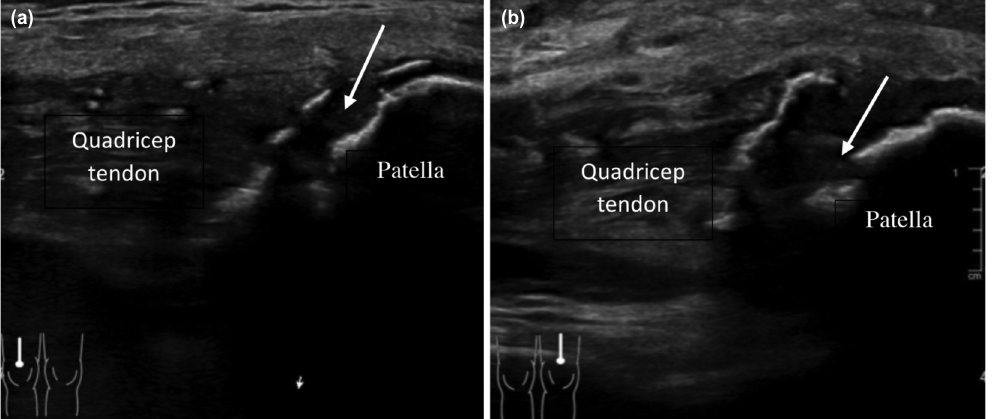
Ultrasound of bilateral knee shows the gap (arrow) in the quadricep tendon which indicates re-rupture, (a) right knee, (b) left